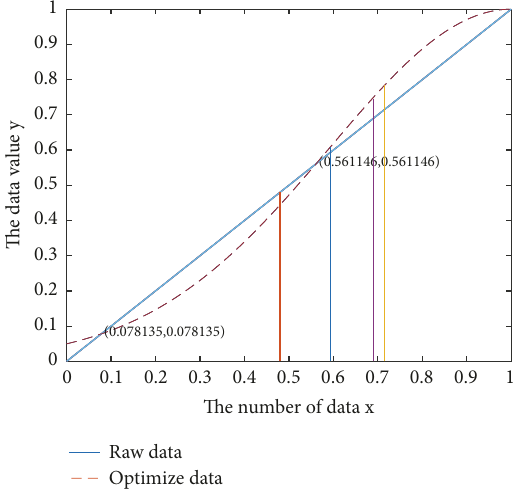
Figure 4: Data optimization comparison curve.